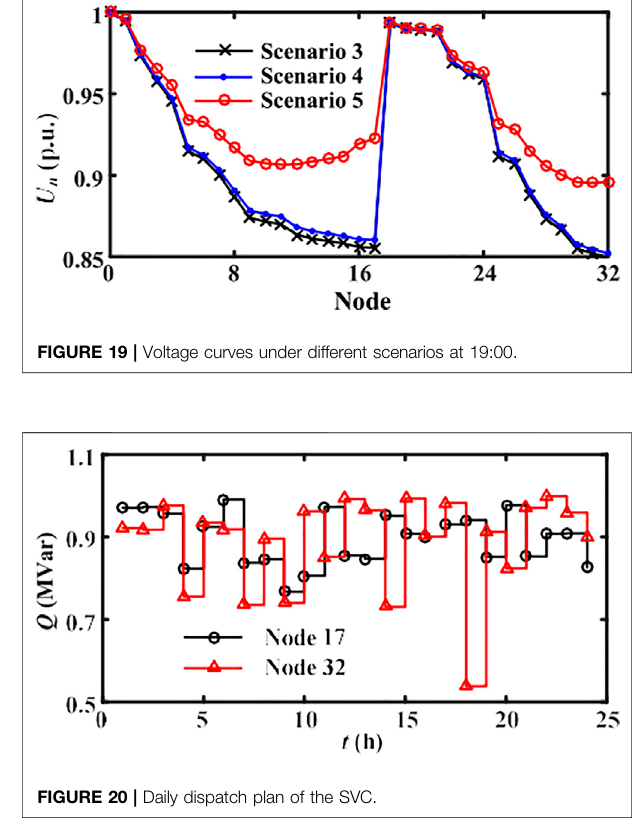
TABLE 2 | Indices before and after compensation at